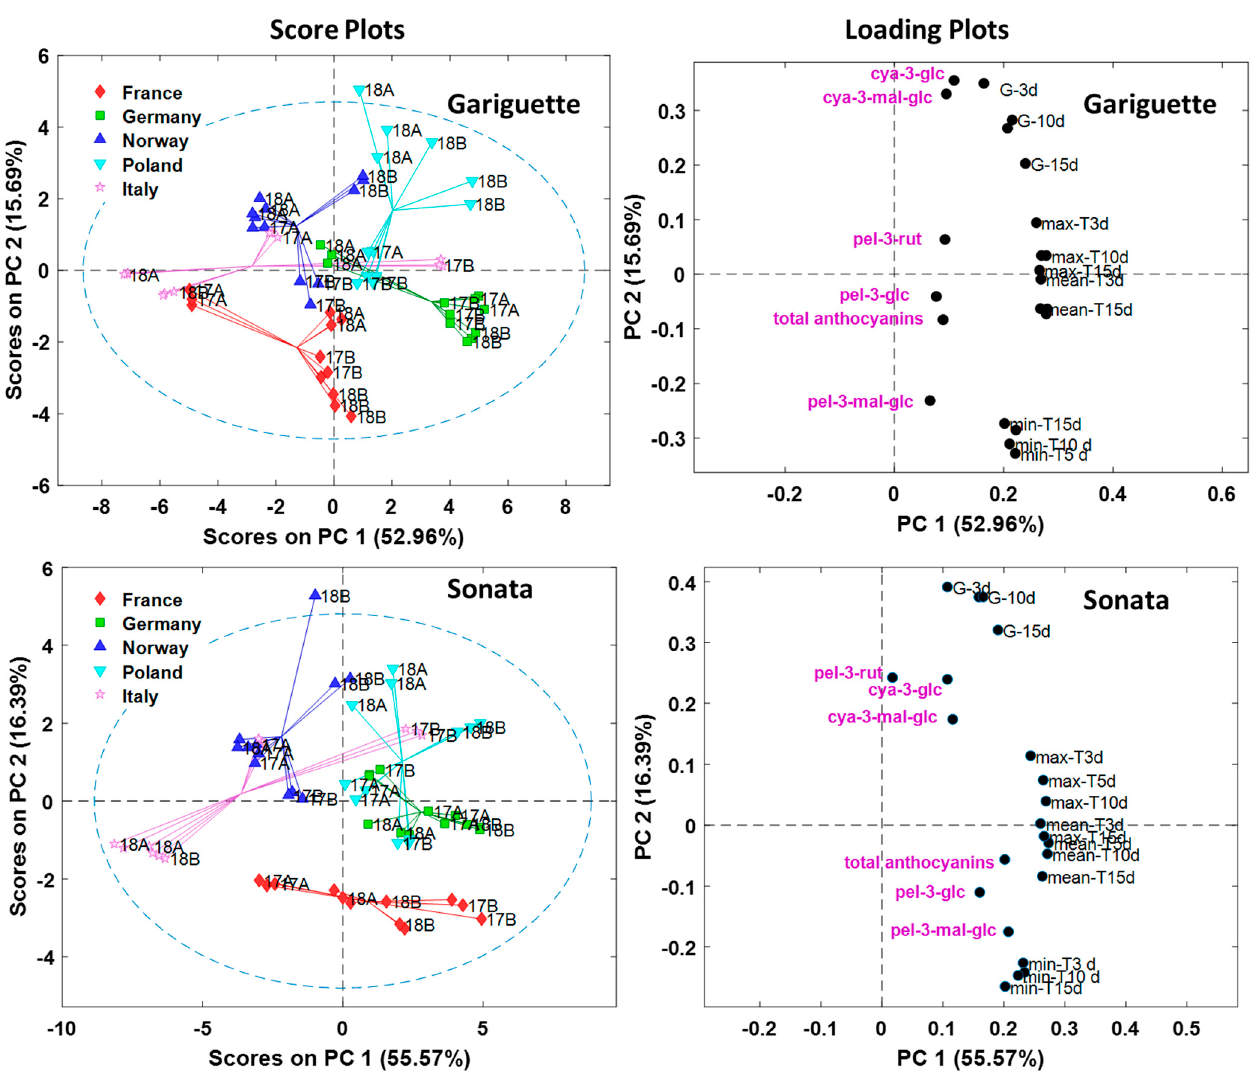
Figure 3. Score and loading plots of PCA for ‘Gariguette’, and ‘Sonata’ grown at five locations (F: France; G: Germany; N: Norway; P: Poland and I: Italy) characterized by total and individual anthocyanin and climatic data. The number and capital letters in the different panel are referring to the year (2017 and 2018, labeled as 17 and 18) and A or B to the harvest date, being one week apart.